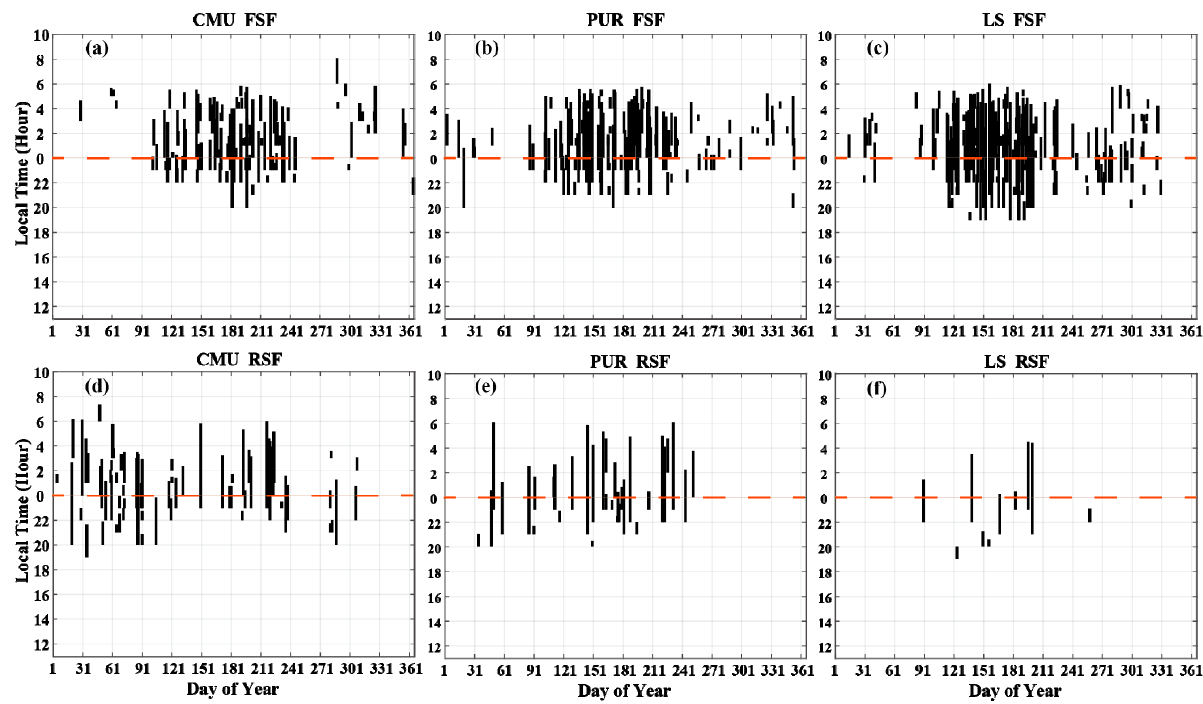
Figure 6. Comparison between annual diurnal variation in SF events marked by FSF and RSF types over CMU, PUR and LS. ( a – c ) the annual diurnal variation of FSF events at CMU, PUR and LS, correspondingly, and ( d – f ) the annual diurnal variation of RSF events at CMU, PUR and LS, correspondingly. The black solid lines indicate the initial time of SF events and their duration time, and the red dotted lines represent the midnight of local time (0